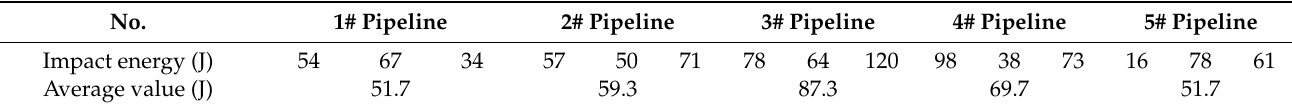
Table 4. Impact energy of welding zone.